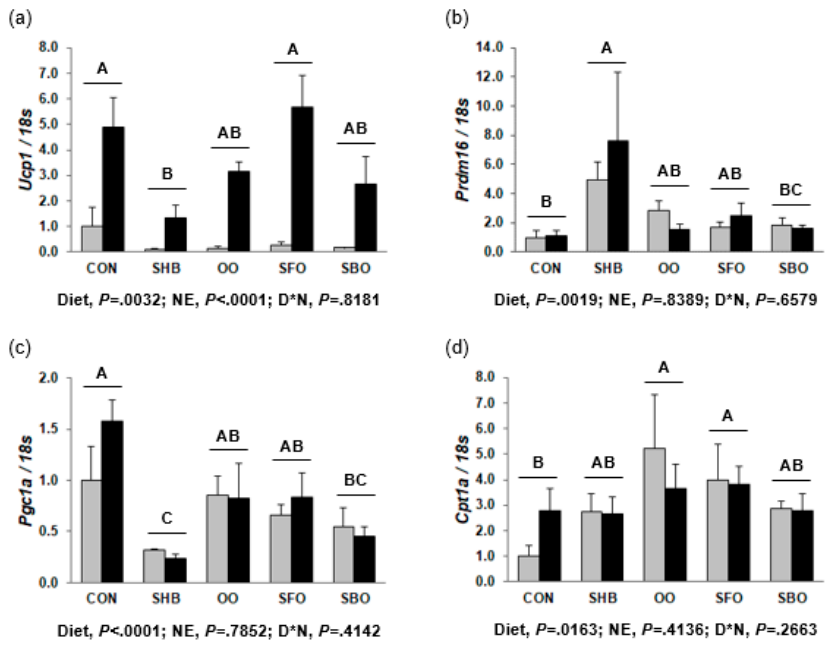
Figure 5. Expression of genes involved in thermogenesis in epididymal WAT ( a ) Ucp1 ( b ) Prdm16 ( c ) Pgc1a ( d ) Cpt1a . Mice were injected with norepinephrine (NE; 2 mg/kg body weight) or phosphate-buffered saline (PBS; 2 mL/kg body weight) as a vehicle after 8-h fasting at the end of the experimental period, and euthanized after another 4-h fasting. Gene expression was determined by RT-PCR. Data are presented as means ± SEM ( n = 8 for each diet group; n = 4 each for PBS and NE). Diets were compared among each other (after combining PBS and NE data within each diet), and assigned different superscripts A, B, AB, BC, or C) if they were significantly different from each other at P < 0.05 by Tukey’s multiple comparison test. If a diet has a common superscript with another diet, it means they are not different. Only diets without a common superscript are significantly different.